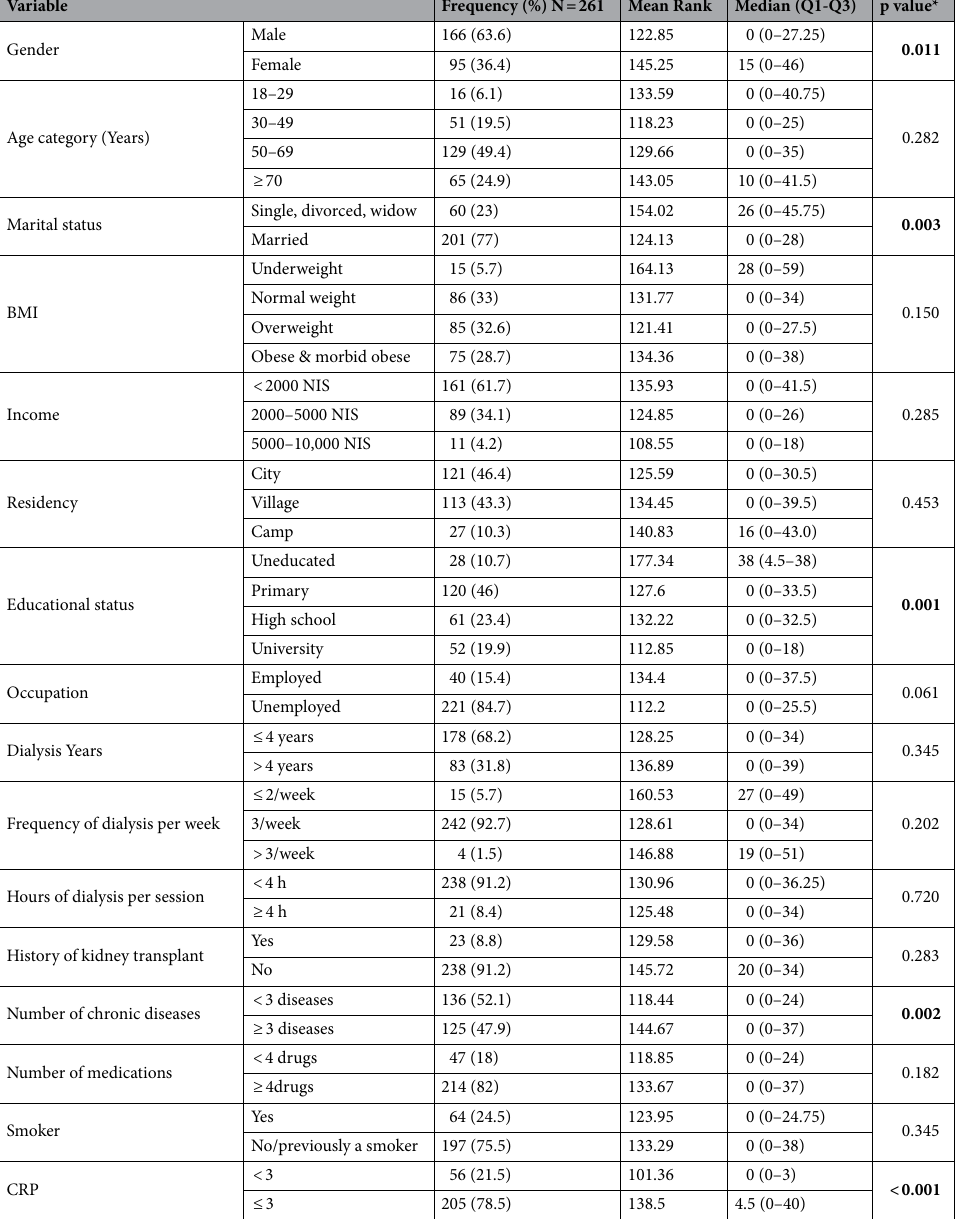
Table 3. Pain interference score by subgroups based on demographic and clinical characteristics. BMI body mass index; CRP C-reactive protein. *The bold p value indicates that < 0.05, which considers significantly.